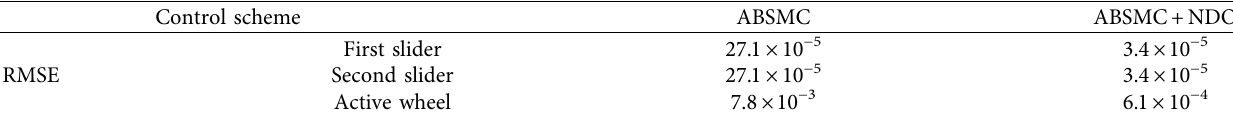
Figure 7: Estimated disturbances for each motor. Table 3: RMSEs for each